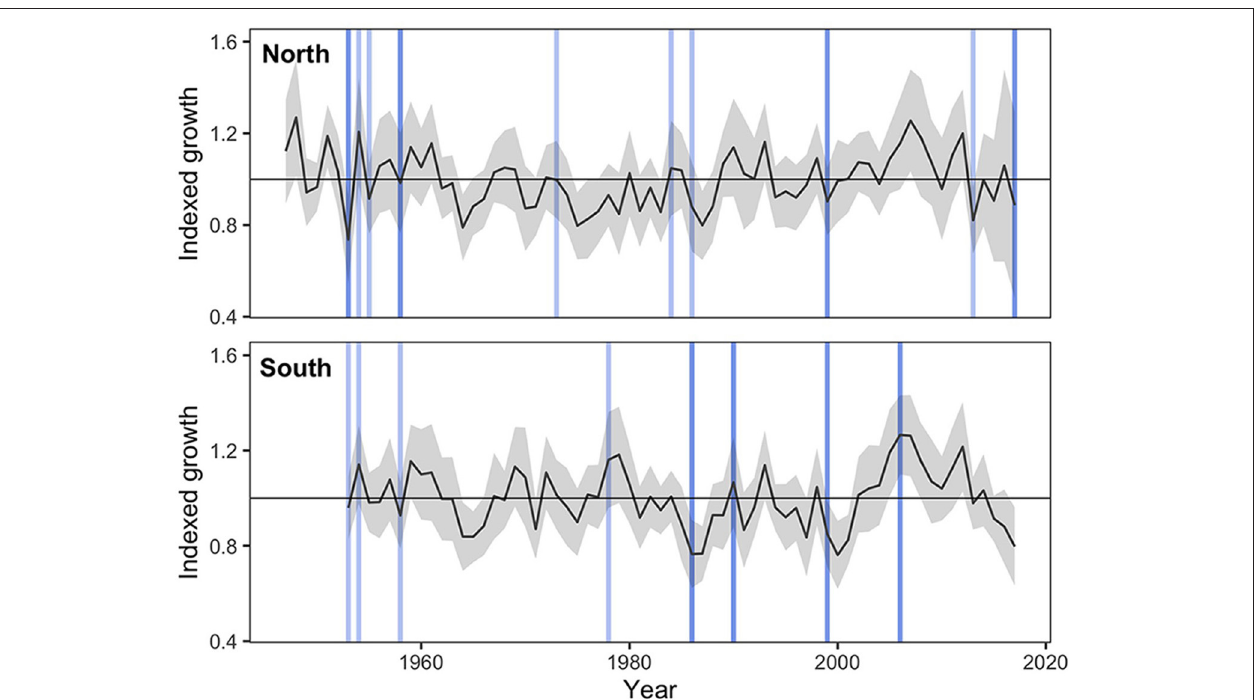
FIGURE 4 | Averaged ring width standardized chronologies ± SD from sampled black spruce for the northern region ( n = 39, EPS = 0.94) and the southern region ( n = 20, EPS = 0.92) for the period 1947–2017 and 1953–2017, respectively. Blue vertical lines illustrate severe spring frosts (SD > 1), with darker lines representing the most severe events (SD > 2). The northern region experienced abrupt growth declines in 1953 (49% of all trees), 1999 (23%), 2013 (38%), and 2017 (67%), all of which coincided with the occurrence of severe spring frosts. In the southern sites, high proportions of trees experienced abrupt growth declines in 1958 (35%), 1986 (35%) and 1999 (45%), which also coincided with years of severe spring frosts.